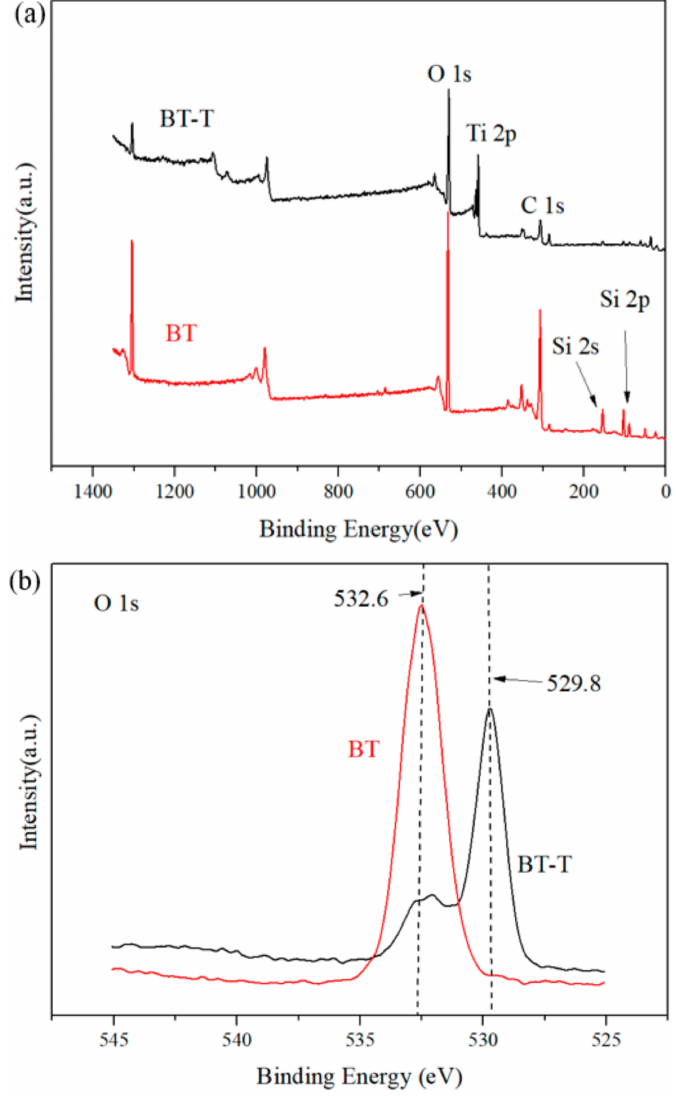
Figure 3. ( a ) XPS survey spectra of BT and BT-T, ( b ) O 1s high-resolution energy spectrum.